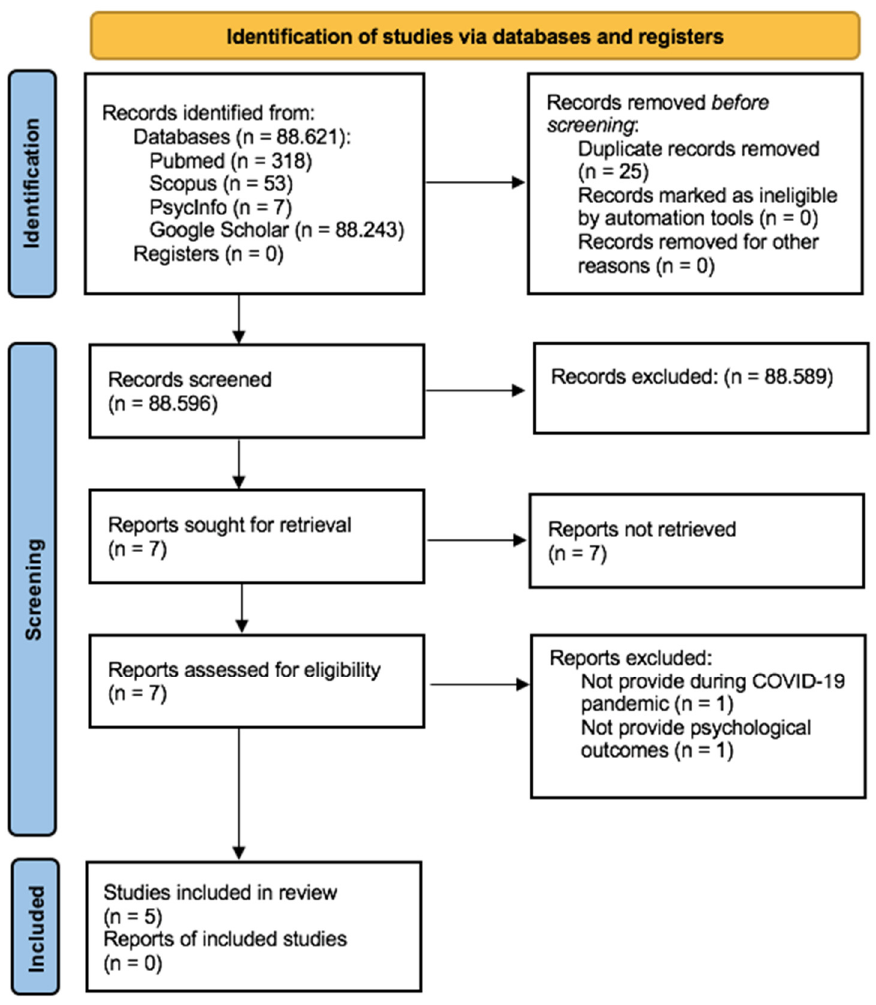
Figure 1. PRISMA Figure 1. PRISMA flowchart.